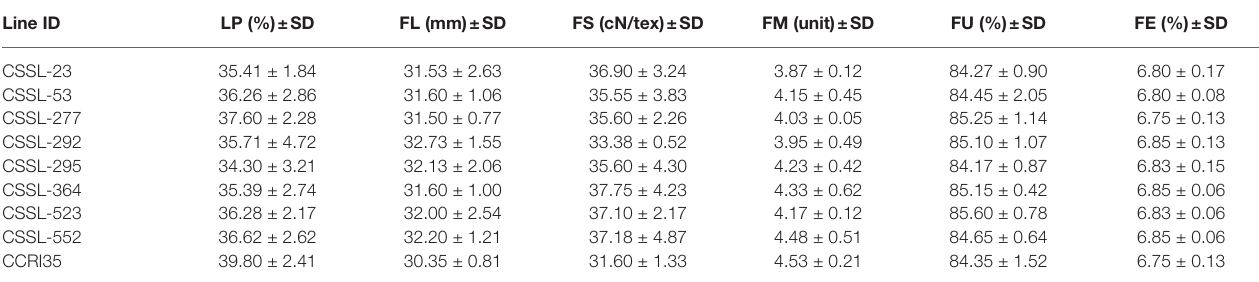
TABLE 3 | Phenotypic means of the eight lines with excellent fiber quality in four environments.